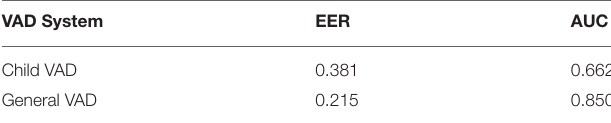
TABLE 2 | Equal-error-rates (EERs) and area-under-the-curve (AUC) for the child voice activity detection system and the general voice activity detection system evaluated on the respective